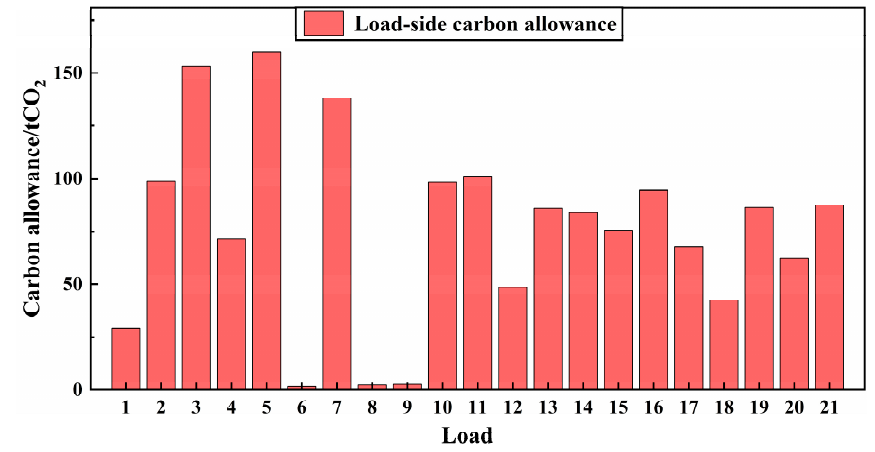
Figure 7. Carbon allowance values of 21 loads.